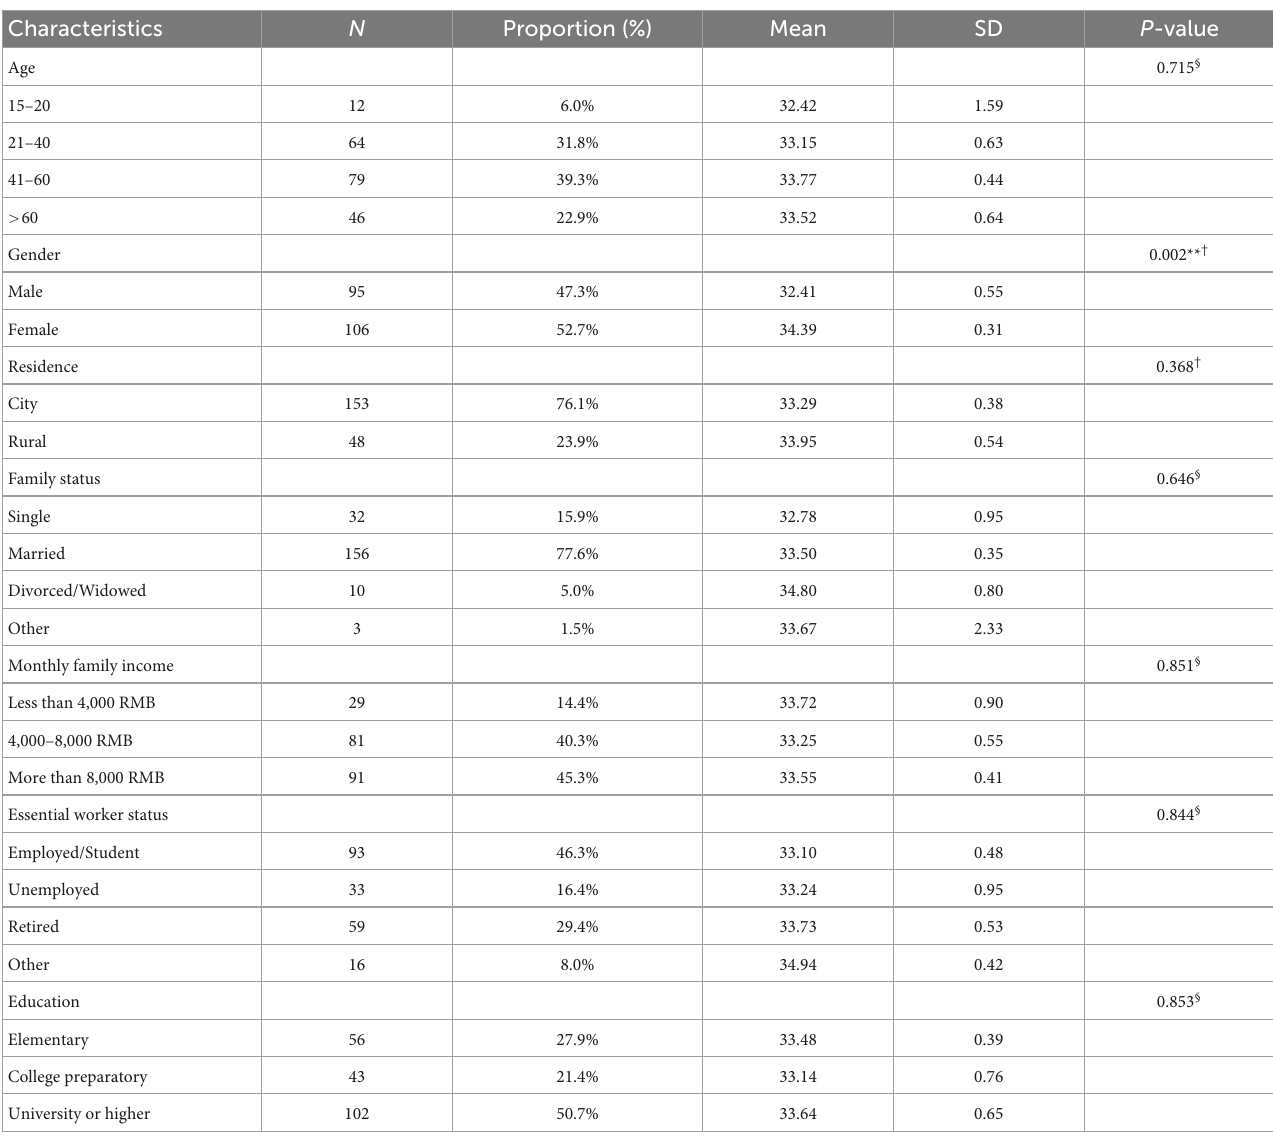
TABLE 1 Sociodemographic characteristics of total sample.